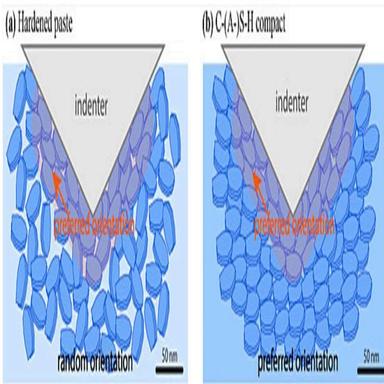
Schematic representation of the development of preferred orientation of C-(A-)S-H nanocrystallites during nanoindentation experiments using (a) hardened paste (e.g., high-volume fly ash cement or alkali-activated blast-furnace slag) and (b) C-(A-)S-H compact. The development of the texture of samples in micro indentation experiments is similar to that of nanoindentation. Image reproduced from.